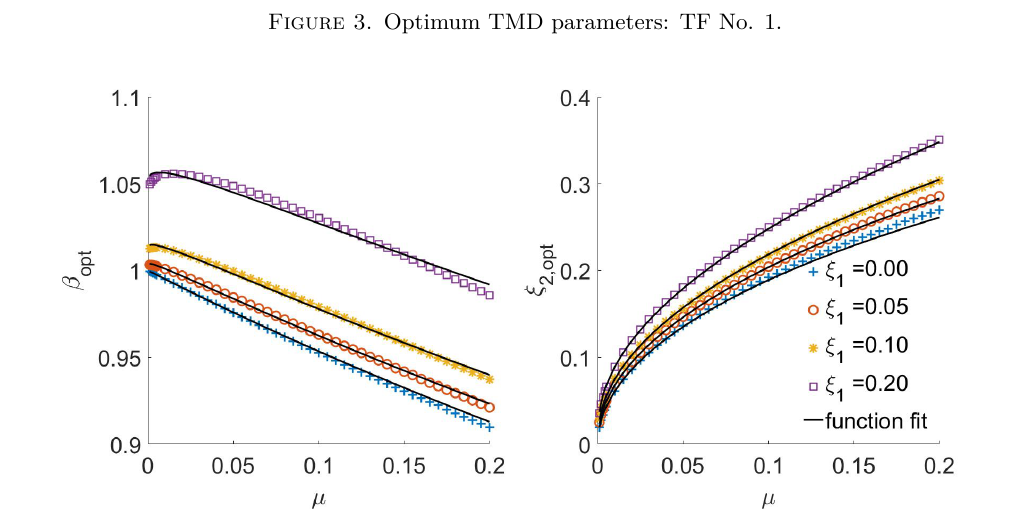
Figure 4. Optimum TMD parameters: TF No. 2.